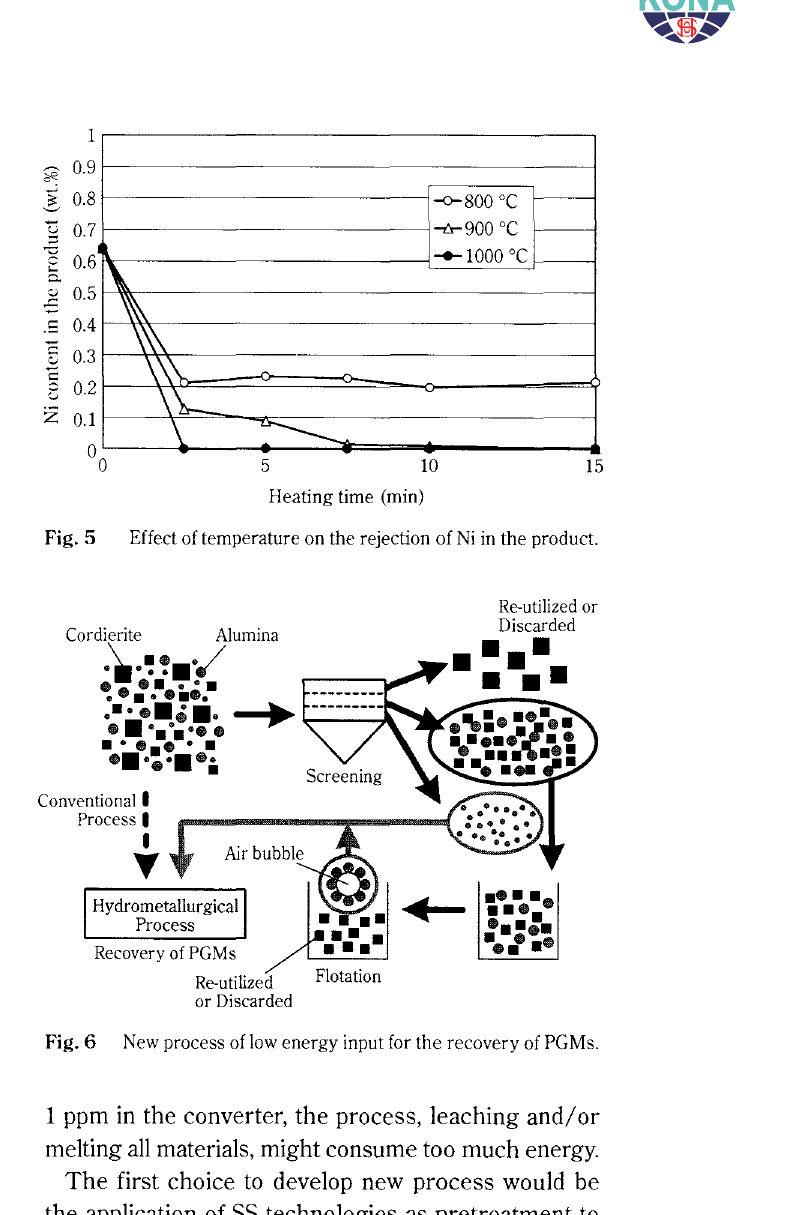
Fig. 6 New process of low energy input for the recovery of PGMs.